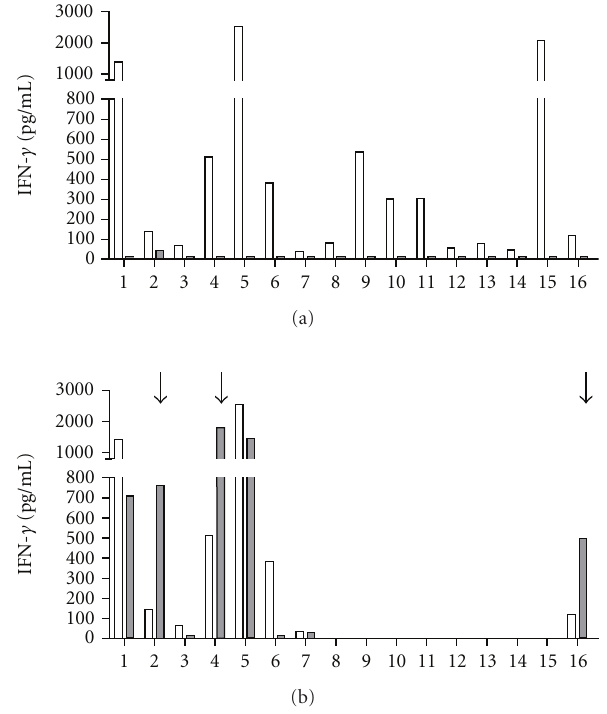
Figure 4: E ff ect of the CD4 + or CD8 + depletion on the FHA- induced IFN- γ production by PBMC from B. pertussis -infected or vaccinated children. Isolated PBMC were stimulated in vitro for 72h with 1 μ g/mL FHA after CD4 + (a) or CD8 + (b) depletion. Results from infected children are represented by columns 1 to 5 whereas those from vaccinated children are indicated by numbers 6 to 16. Open columns represent the values obtained for the nondepleted cell suspension and grey columns those obtained after CD4 + or CD8 + depletions. The arrows indicate the samples characterized by a higher IFN- γ secretion in CD8-depleted cell suspension compared to the